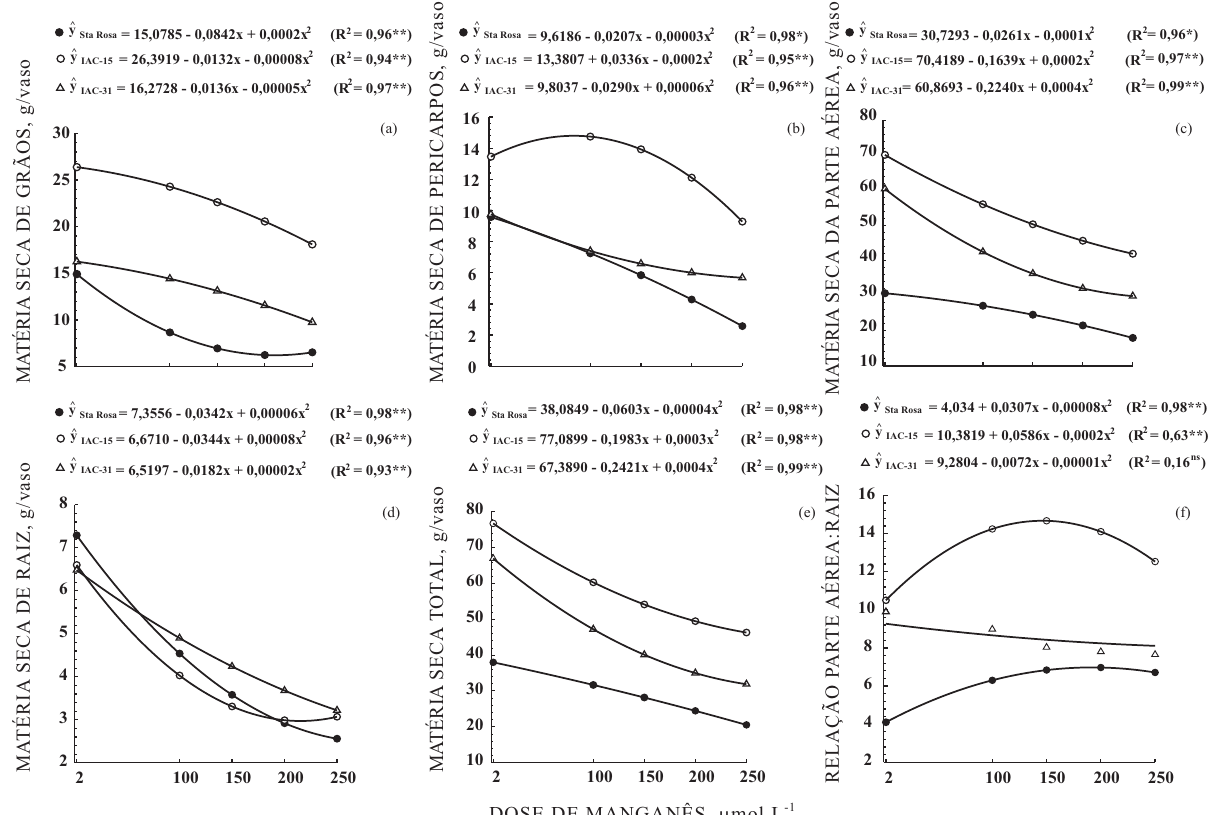
Figura 4. Produção de matéria seca (a) de grãos, (b) de pericarpos, (c) de matéria seca da parte aérea, (d) de raízes, (e) de matéria seca total e (f) relação parte aérea:raiz dos cultivares Santa Rosa ( ), IAC-15 ( ) e IAC-Foscarin 31 ( ΔΔΔΔΔ ), considerando as doses de 2, 100, 150, 200 e 250 μ mol L -1 de Mn, em solução